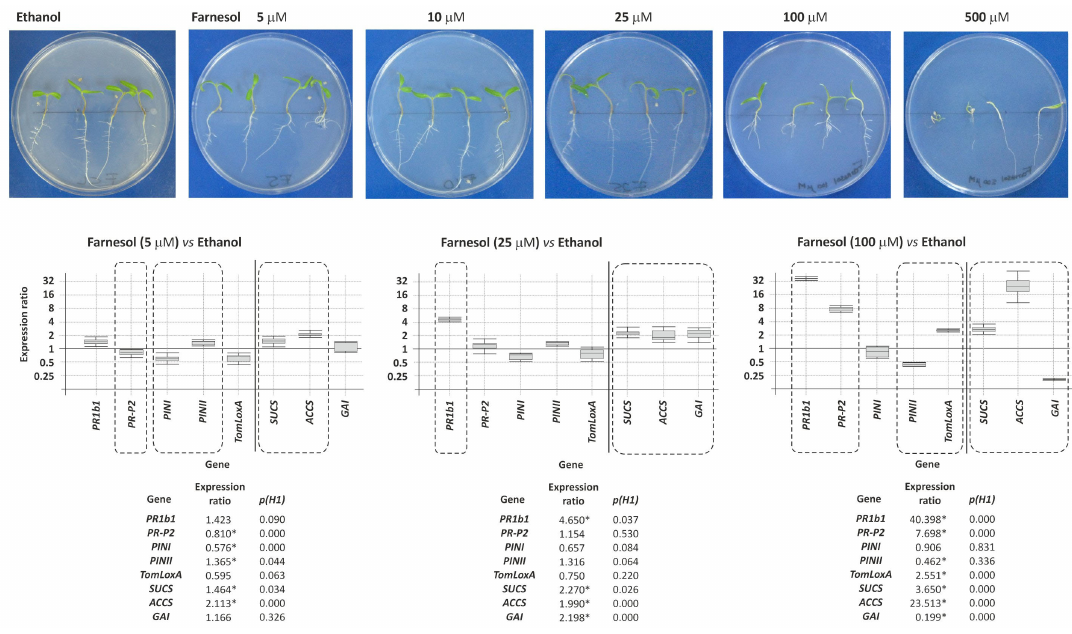
Figure 7. Analysis of the effect of different farnesol concentrations on the growth of tomato plantlets ( Upper panels ) and the relative expression of five tomato defense ‐ related genes: PR1b1 and PR ‐ P2 , related to the salicylic acid signaling pathway, and PINI , PINII and TomLoxA related to the jasmonate/ethylene signaling pathways, and three development ‐ related genes: SUCS , ACCS , and GAI , as determined by quantitative PCR ( Lower panels ). In the graphic representation, those statis ‐ tically significant differential expression data ( p < 0.05) are squared with dashed lines and numeric values were labeled with an asterisk (*) at the bottom of each graphic.. The expression of plant defense related genes in health and B. cinerea ‐ infected plants differed markedly. In infected plants, PR1b1 and PR ‐ P2 genes were relatively up ‐ regu ‐ lated, with ratios of 6.3 ( p = 0.000) and 13.5 ( p = 0.000), respectively. In contrast, among the genes related to the JA/ET signaling pathway, only PINI was up ‐ regulated [3.4 ( p = 0.000) fold], whereas PINII and TomLoxA were down ‐ regulated (Figure 8). The up ‐ regulation of SA ‐ related genes ( PR1b1, PR ‐ P2 ) has been also previously observed in response to necrot ‐ rophic pathogens or to volatile organic compounds produced by these pathogens [28]. A possible explanation for the higher level of expression of SA ‐ related genes in T34 ‐ dpp1.3 ‐ treated plants in the presence of B. cinerea could be that the increased farnesol production and/or concomitant deregulation of ergosterol biosynthesis could induce a higher level of sensitization of plants against fungal plant pathogens. 3.8.4. Effect of Increased Farnesol Production on Root Colonization Roots of hydroponic grown tomato plants were inoculated with T34 ‐ 43b1.3 (control strain) and T34 ‐ dpp1.3 to determine the effect of dpp1 ‐ overexpression in T. harzianum on the tomato root colonization ability. For this analysis, qPCR was used to monitor the levels of the tomato glyceraldehyde 3 ′‐ phosphate dehydrogenase gene ( gpd ) versus the T. harzi ‐ anum ‐ actin gene ( act1 ). The analysis revealed that the relative level of T. harzianum act1 in roots from T34 ‐ dpp1.3 treated plants was only 52% of the level in roots of plants treated